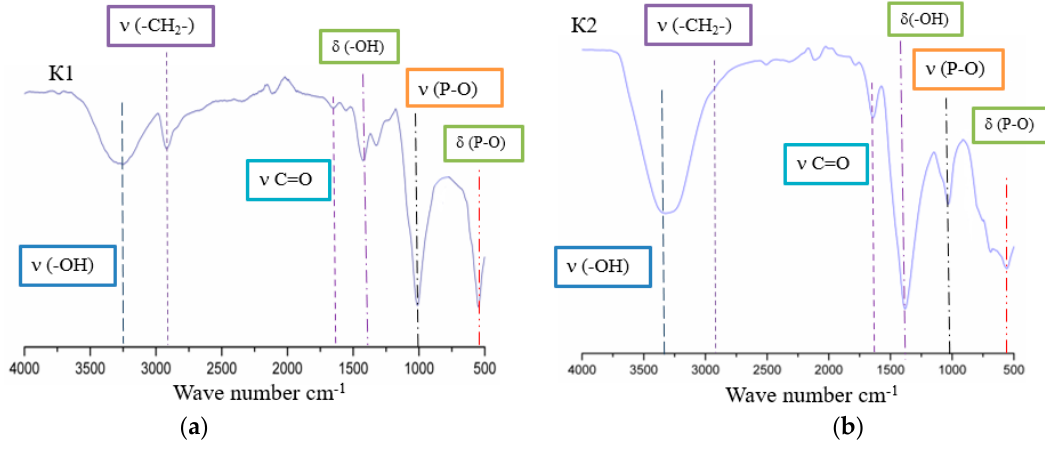
Figure 1. IR spectra of samples of composites K1 ( a ) and K2 ( b ).